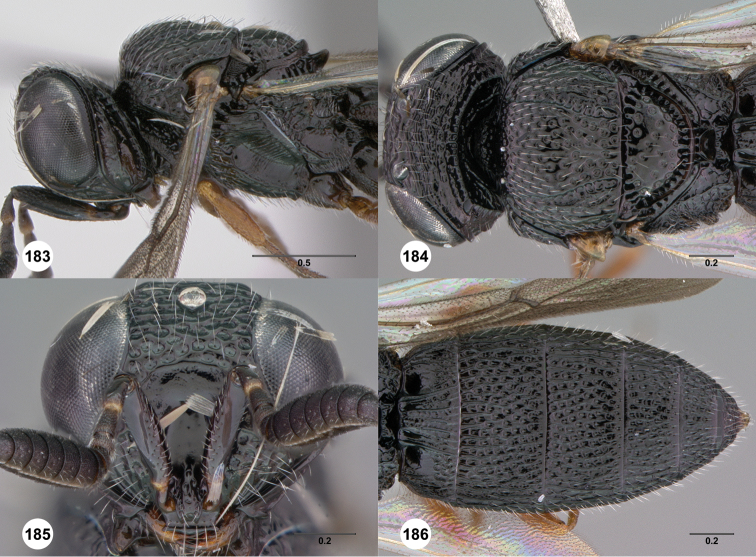
Oxyscelio magniclava (Dodd), female (OSUC 441388) 183 Head and mesosoma, lateral view 184 Head and mesosoma, dorsal view 185 Head, anterior view 186 Metasoma, dorsal view. Morphbank63